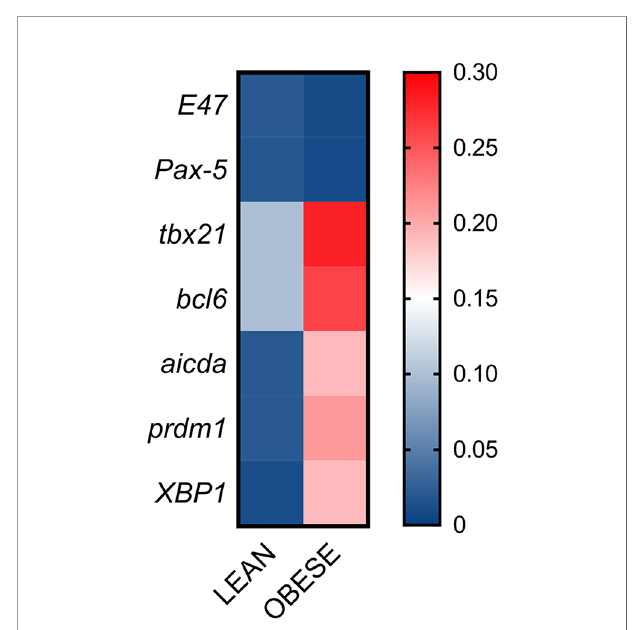
analysis in Figure 4B distinct clustering of DN B cells from the two groups of individuals are shown.